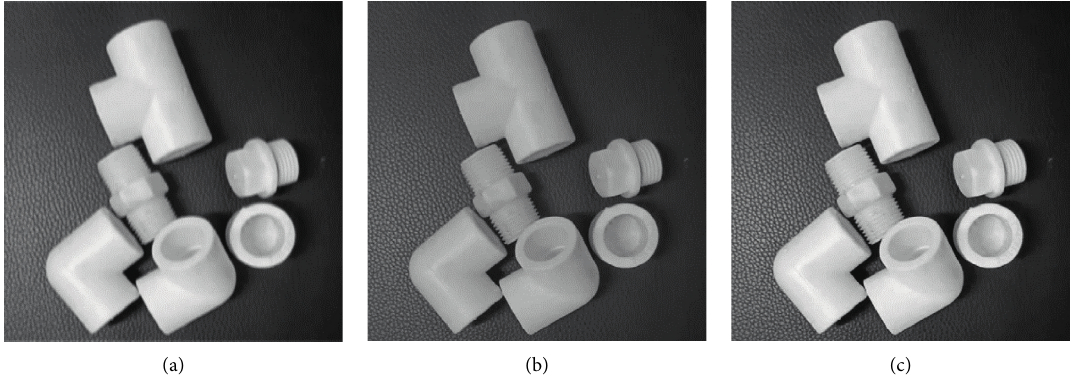
Figure 3: Comparison between the original image and processed image. (a) The original image. (b) Grayscale processing. (c) Grayscale processing.